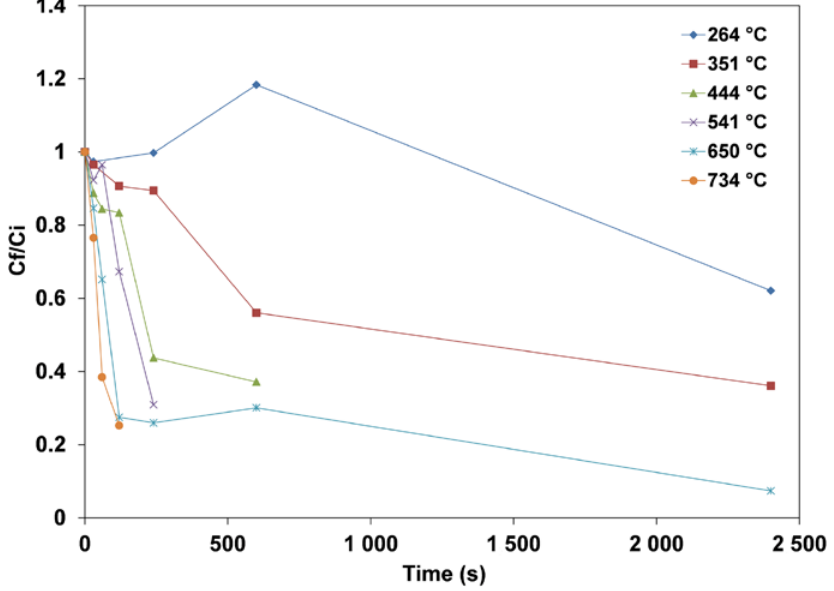
Figure 12. Carbon ratio for different temperatures.